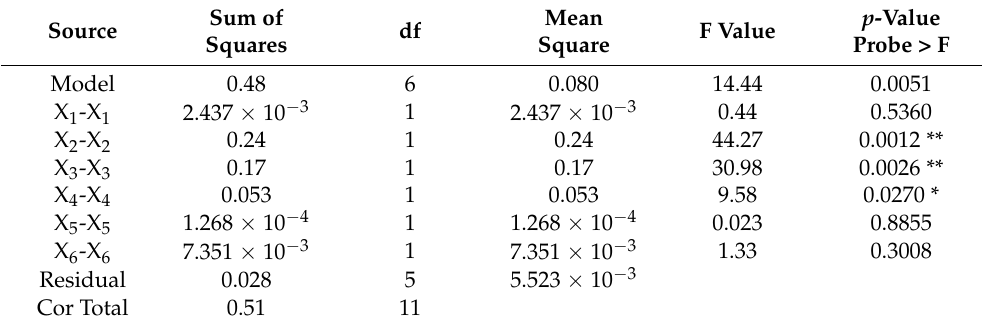
Table 2. The effect value of each factor and its significance